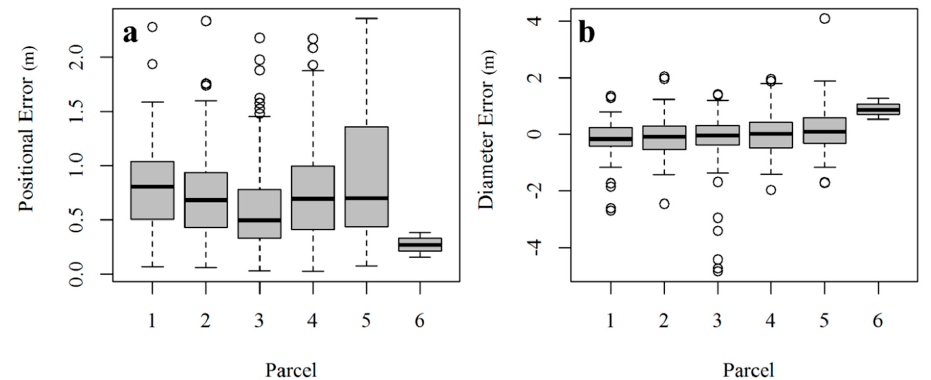
Figure 7. ( a ) Box plot of positional error (m) of individual tree crowns; ( b ) box plot of diameter errors (m) of an individual tree crowns; the plots represent the minimum, first quartile, median, third quartile, maximum, and outliers for the respective errors in the crowdsourced data over the parcels.